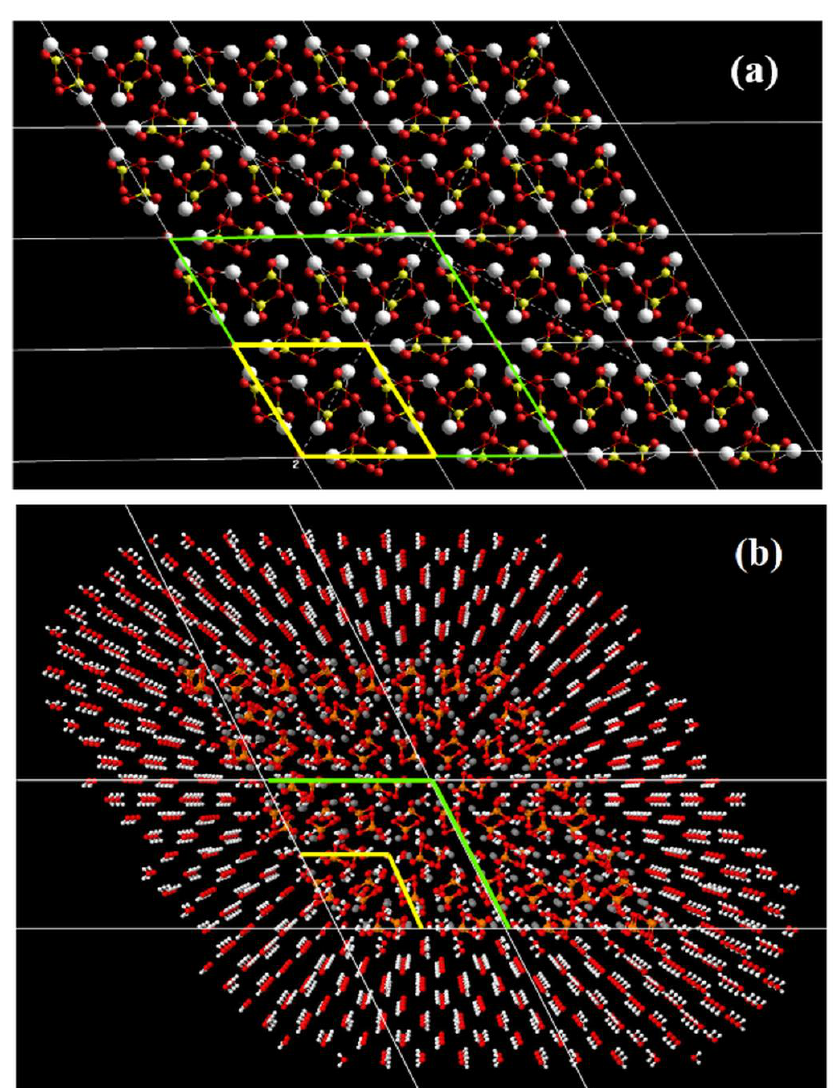
Figure 2. Super-cell 2 × 2 × 2 = 8 HAP unit cell model: ( a ) in c -axis projection — perpendicular to OH- channel (see in center), the unit cell is shown by yellow lines; ( b ) in b-axis projection — the OH groups in vertical line positions for the P6 3 phase.